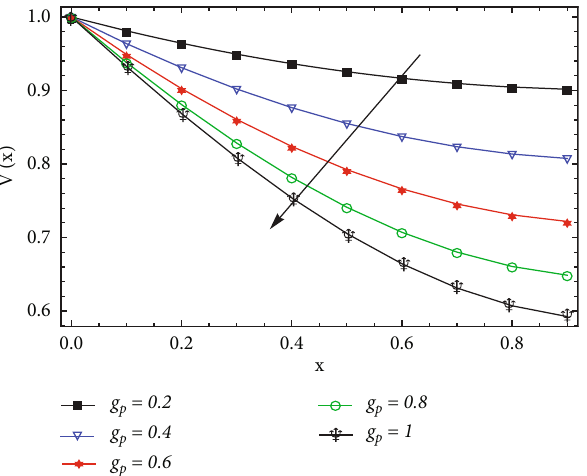
Figure 2: In lifting case e ff ect of g β = 1 are fi xed.